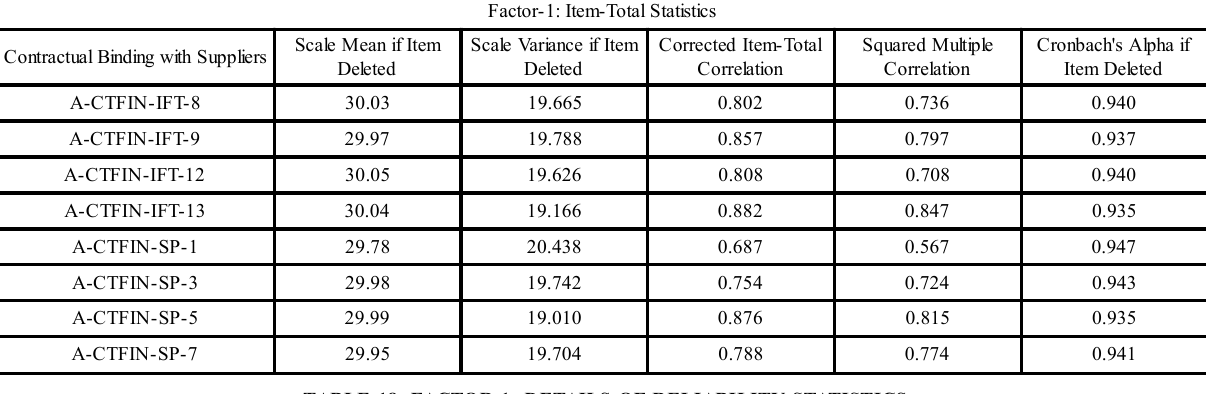
TABLE 18. FACTOR-1; DETAILS OF RELIABILITY STATISTICS